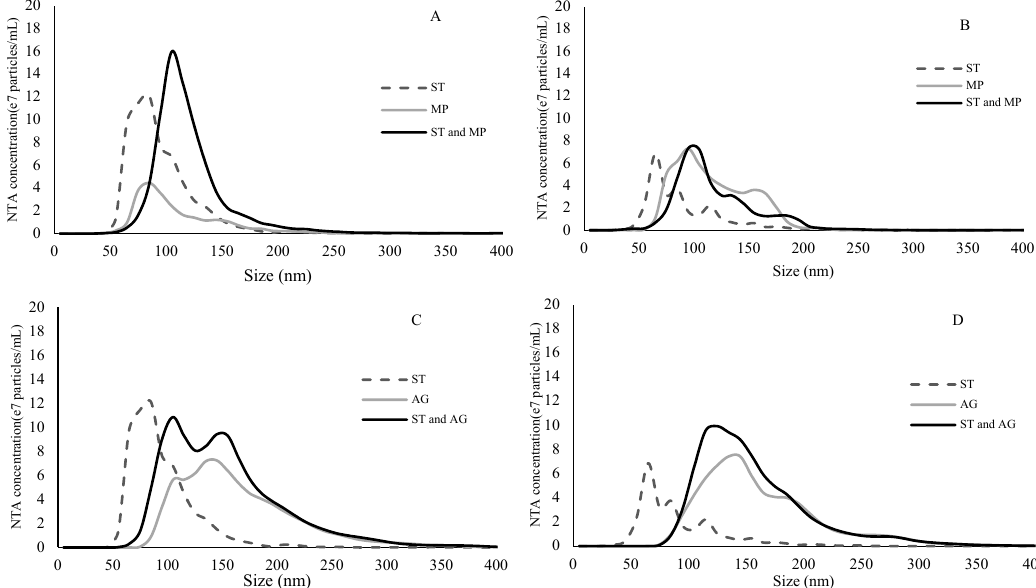
Figure 3. Size distribution of binding experiments between 1.25 mg/mL tannin and 0.5 mg/mL polysaccharides determined by nanoparticle tracking analysis. The curves were an average of 15 measurements. ( A ) ST and MP in 12% ethanol model wine; ( B ) ST and MP in 15% ethanol model wine; ( C ) ST and AG in 12% ethanol model wine; and ( D ) ST and AG in 15% ethanol model wine. All ST-containing solutions were diluted 1:10 with model wine prior to analysis.